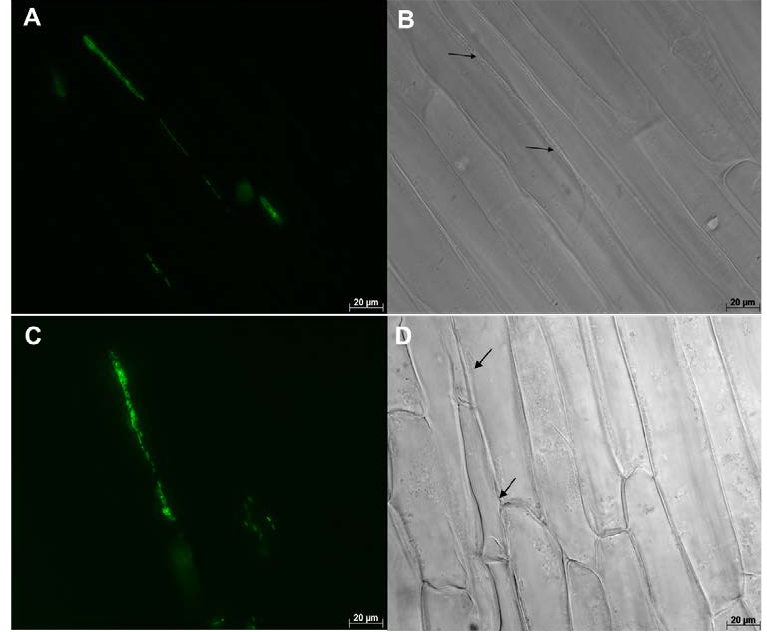
Figure 2. Maize (hybrid 29B17) roots colonized by WP5 gfp visualized under 630× magnification. Image on the left ( A , C ) were taken with the GFP filter, and images on the right ( B , D ) were taken without the GFP filter. Groups of WP5 gfp cells were observed in the intercellular spaces of cell layers in the longitudinal direction.